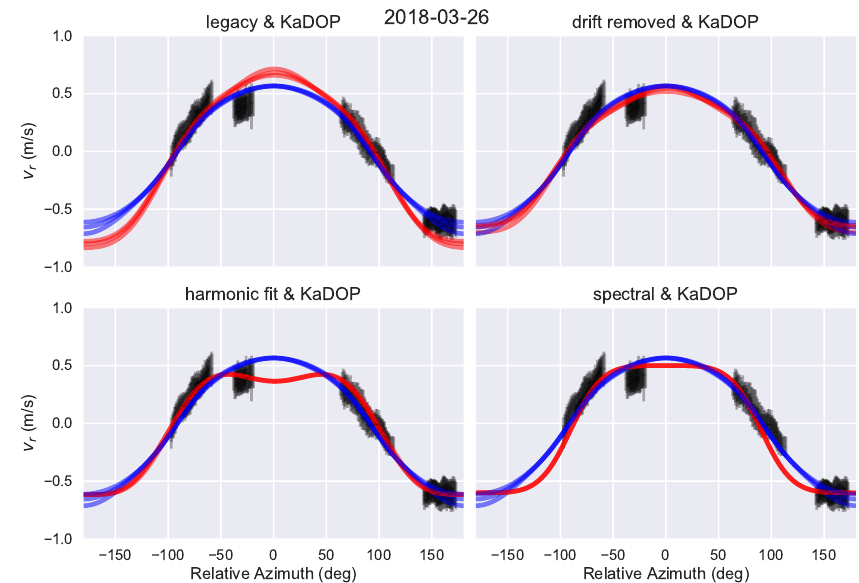
Figure 16. The gray error bars are the mean-centered standard deviations of the values of F CR (Equation (9)) binned by wind speed (6 m/s and 7 m/s bins) and azimuth direction relative to the scatterer direction. The two wind speed bins overlie each other, and are plotted using the same color for clarity, as expected from previous results. The red lines are CGMF estimates for various candidate CGMFs considered: (1) the legacy CGMF in [4] (upper left); (2) the legacy CGMF with a wind drift correction applied (upper right); (3) 4th order harmonic fit to the experimental data (lower left); (4) fit assuming a cos 2 s ( φ /2 ) spectrum. The blue lines are estimated from the KaDOP CGMF of Yurovsky et al. [35]. Data are for 2018-03-26.